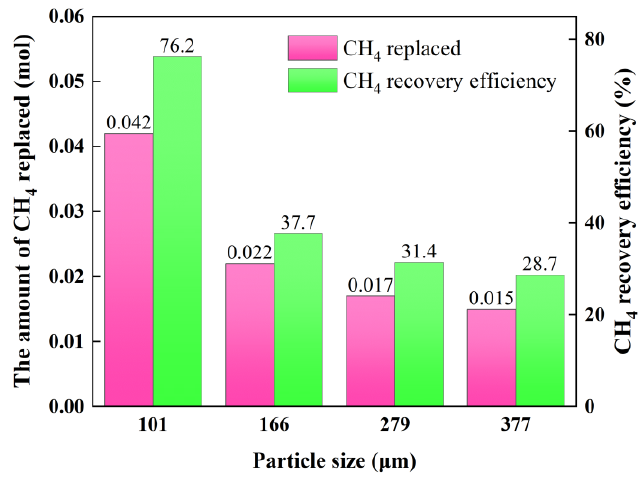
Figure 11. The recovery efficiency and replacement amount of CH 4 for Experiments 1, 2, 3, and 4. The calculated recovery efficiency of CH 4 hydrate for Experiments 5–8 is shown in Figure 12.